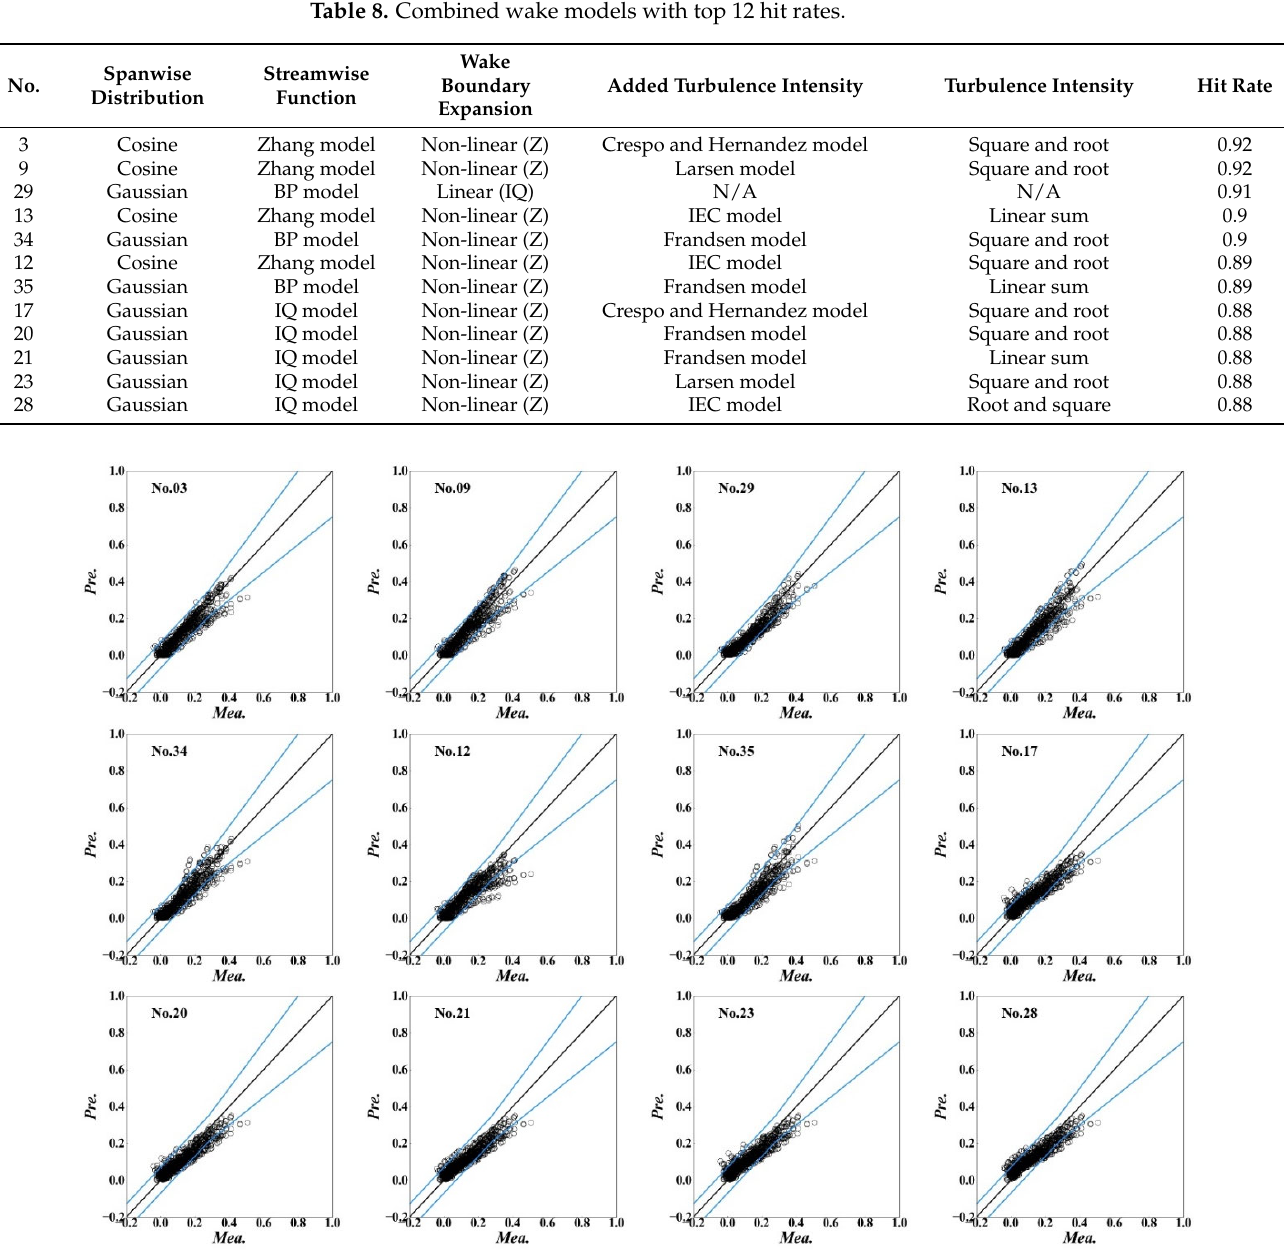
Figure 8. Comparison between predictions by combined wake models and measurements (blue line: threshold values; black line: Mea. = Pre ; dot: velocity deficit).